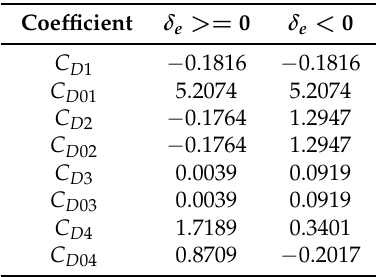
Table 7. Coefficient of drag